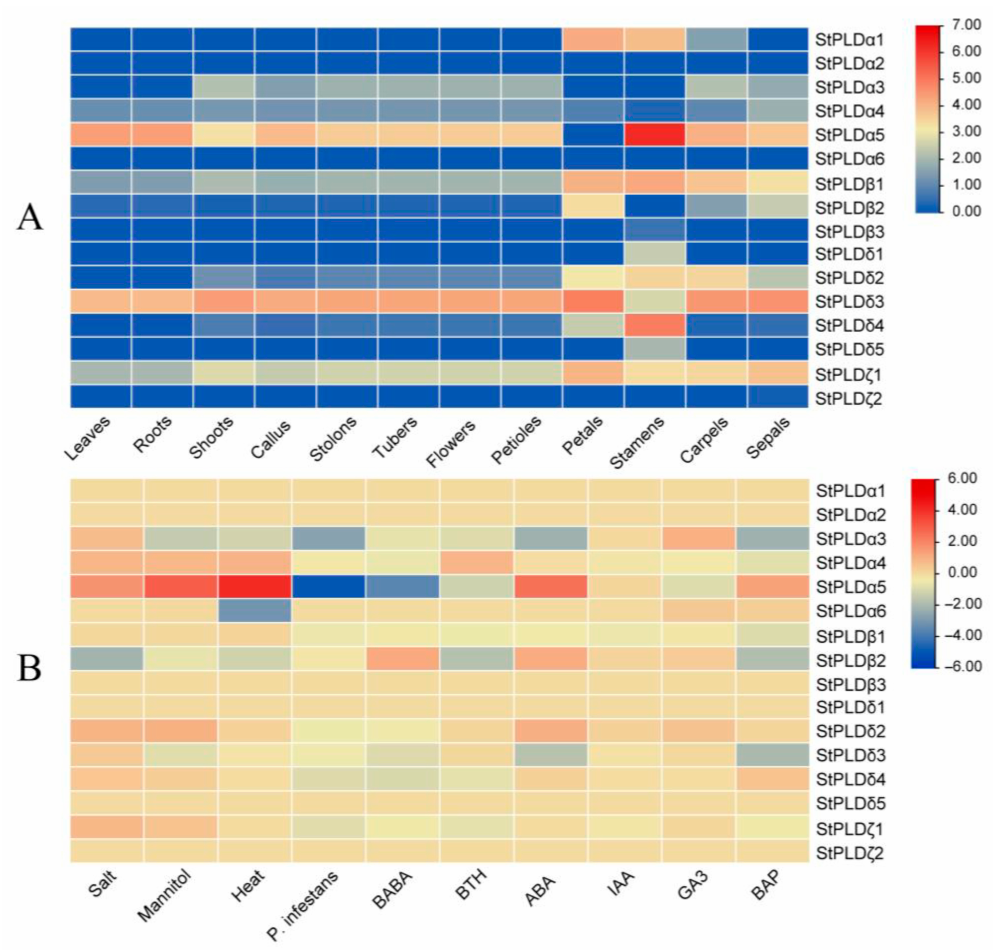
Figure 8. ( A ) Heatmap shows the expression of StPLD gene in 12 tissues, including the leaves, roots, shoots, callus, stolons, tubers, flowers, petioles, petals, stamens, carpels, sepals. Red indicates high relative gene expression, whereas blue indicates low relative gene expression. ( B ) Heatmap of the expression profile of potato PLD genes under 10 different biotic or abiotic stresses. Abiotic stresses included salt, mannitol, and heat; biotic stresses included DL-b-amino-n-butyric acid (BABA), stress-elicitors acibenzolar-S-methyl (BTH), and Phytophthora infestans; and other stress responses were mainly induced by four plant hormones: 6-benzylaminopurine (BAP), indole-3-acetic acid (IAA), abscisic acid (ABA), and gibberellic acid (GA3). Red indicates gene upregulation, while blue indicates gene downregulation.